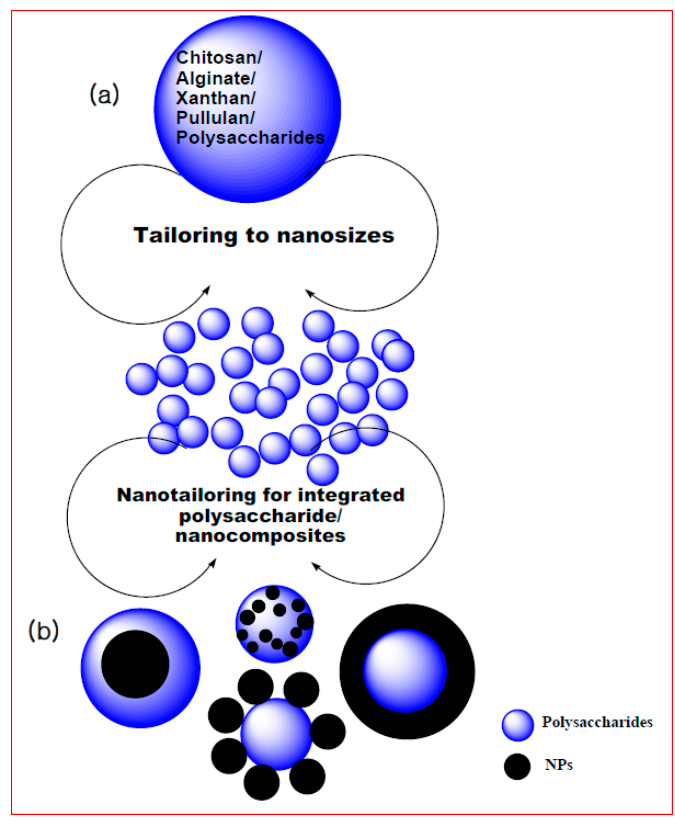
Figure 2. Future perspective of biosorption realized through: ( a ) nanosizing polysaccharides; and ( b ) integrating polysaccharides with nanoparticles (NPs) forming polysaccharide nanocomposites.